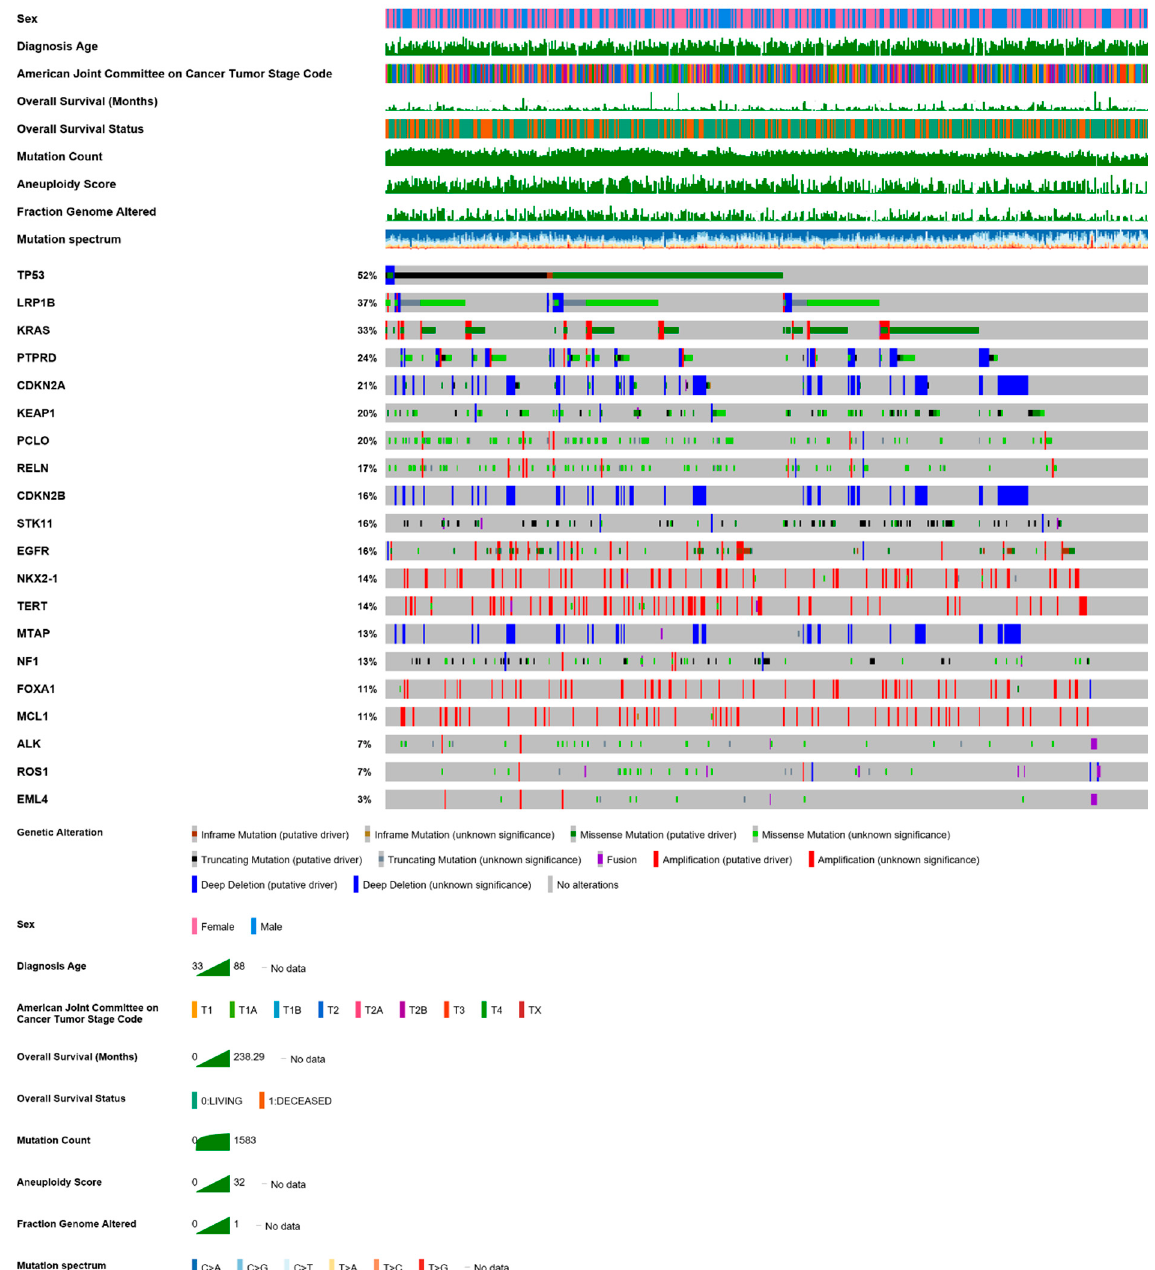
Figure 1. A current mutation plot of the most frequently altered genes in the TCGA pan-cancer Lung adenocarcinoma (LUAD) dataset ( n = 507). Queried genes ( TP53, LRP1B, KRAS, PTPRD, CDKN2A, KEAP1, PCLO, RELN, CDKN2B, STK11, EGFR, NKX2-1, TERT, MTAP, NF1, FOXA1, MCL1, ALK, ROS1, EML4 ) were altered in 475 (94%) of patients. Note the heterogeneity and mosaic complexity of mutations in key cancer genes. Note also the multiple mutual exclusivity and addiction patterns that are used to provide clues to which genes are candidate drivers or passengers. Data from https://www.cbioportal.org/study/summary?id=luad_tcga_pan_can_atlas_2018 [43,44].